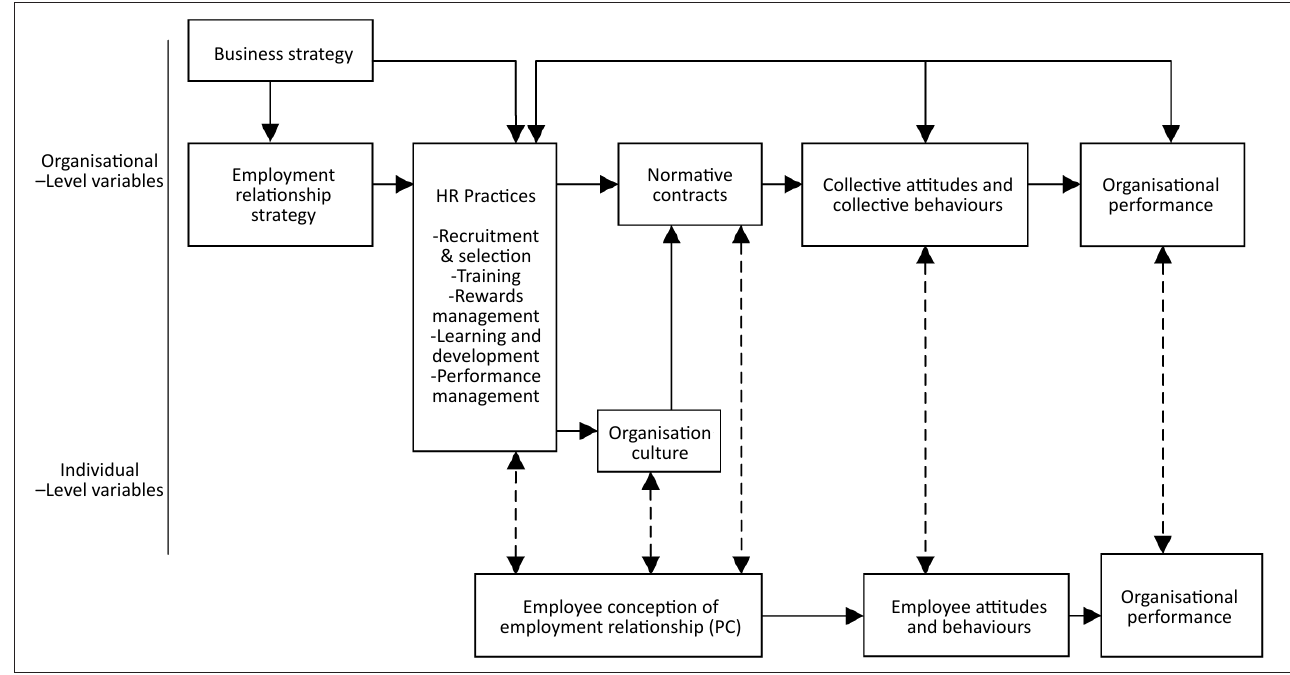
FIGURE 2: A model of the relationship between human resource (HR) practices, psychological contracts and their effects on employee attitudes and behaviours (Aggarwal, U., & Bhargava, S. (2008). Reviewing the relationship between human resource practices and psychological contract and their impact on employee attitude and behaviours: A conceptual model. Journal of European Industrial Training , 33 (1), p.